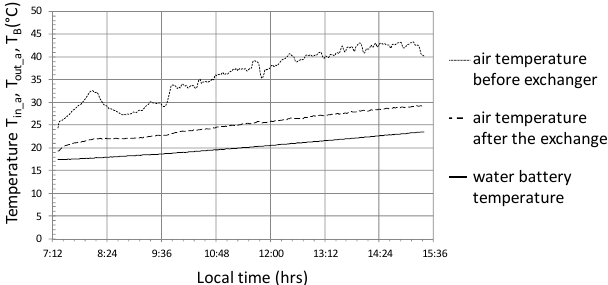
Figure 18. Timescale of temperature distribution in the heat storage system in the water accumulator for cycle No. 1.